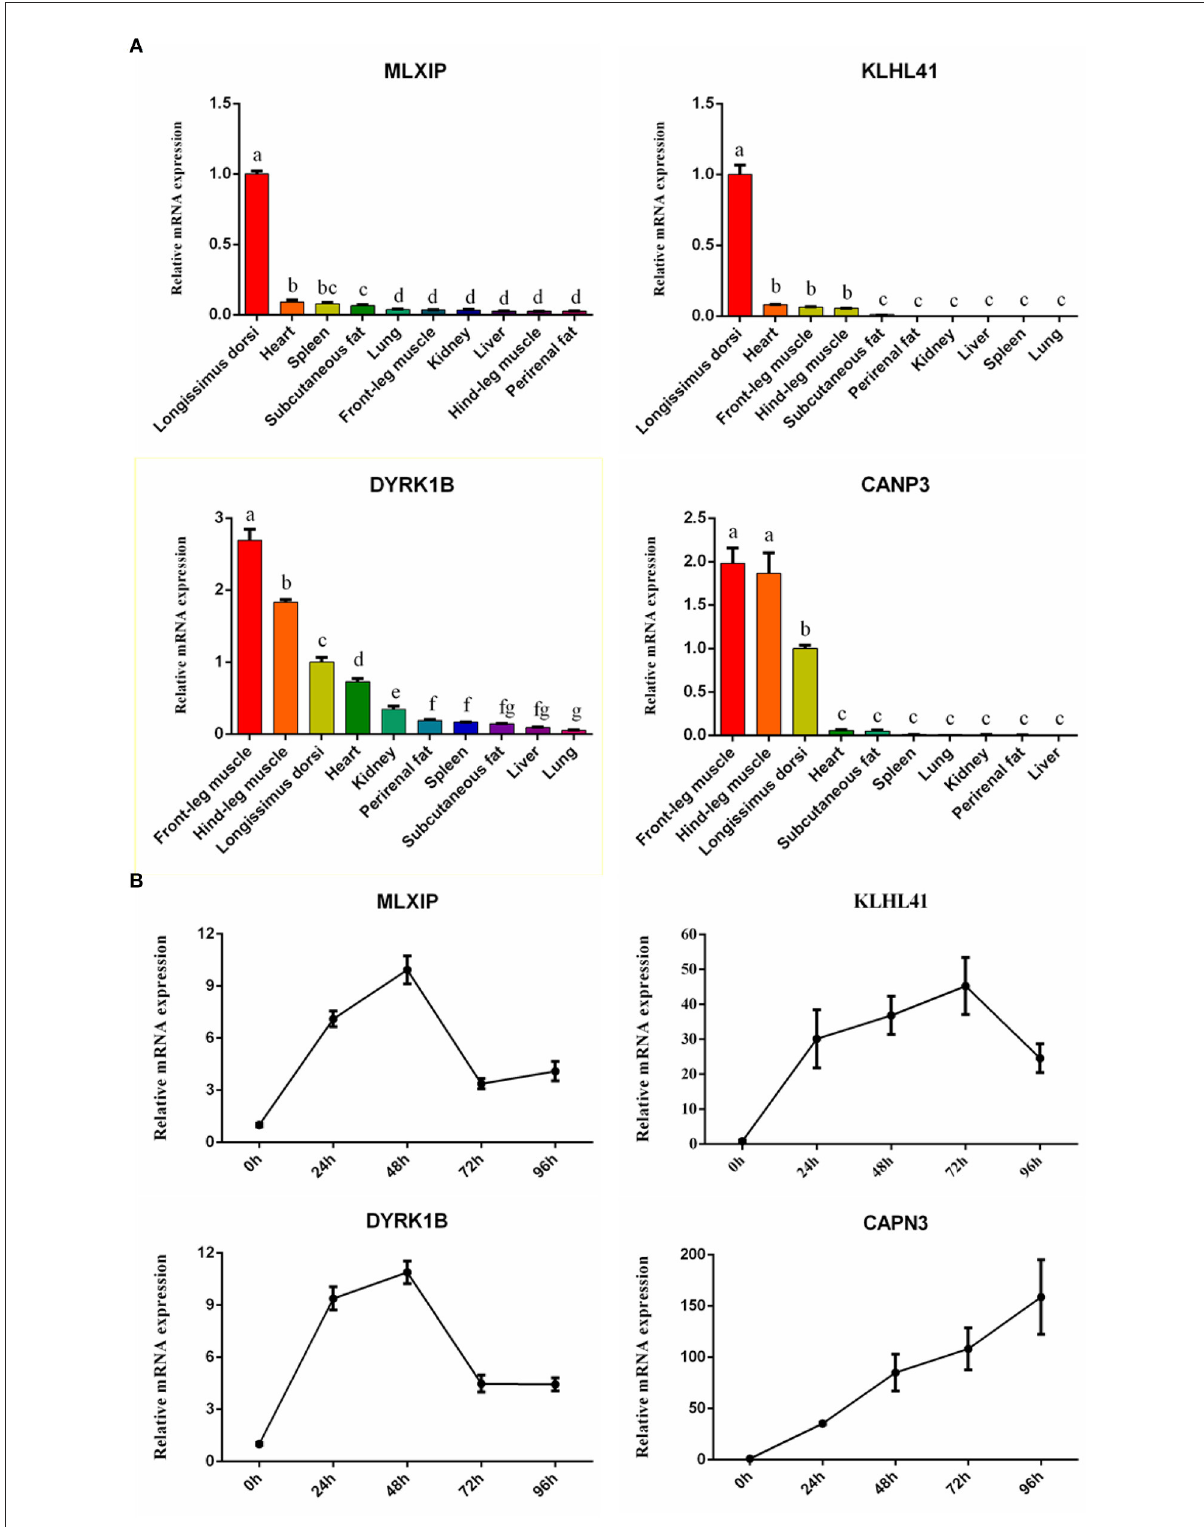
FIGURE8 The relative expression of hub genes by qRT-PCR. (A) The bar plots represented tissue expression profiles. (B) The line charts represented myogenic cell differentiation expression profiles.